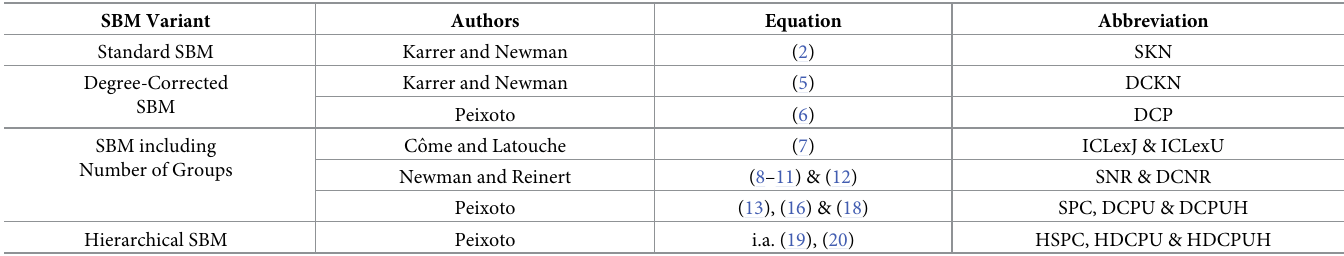
Table 1. SBM variants, authors and assigned